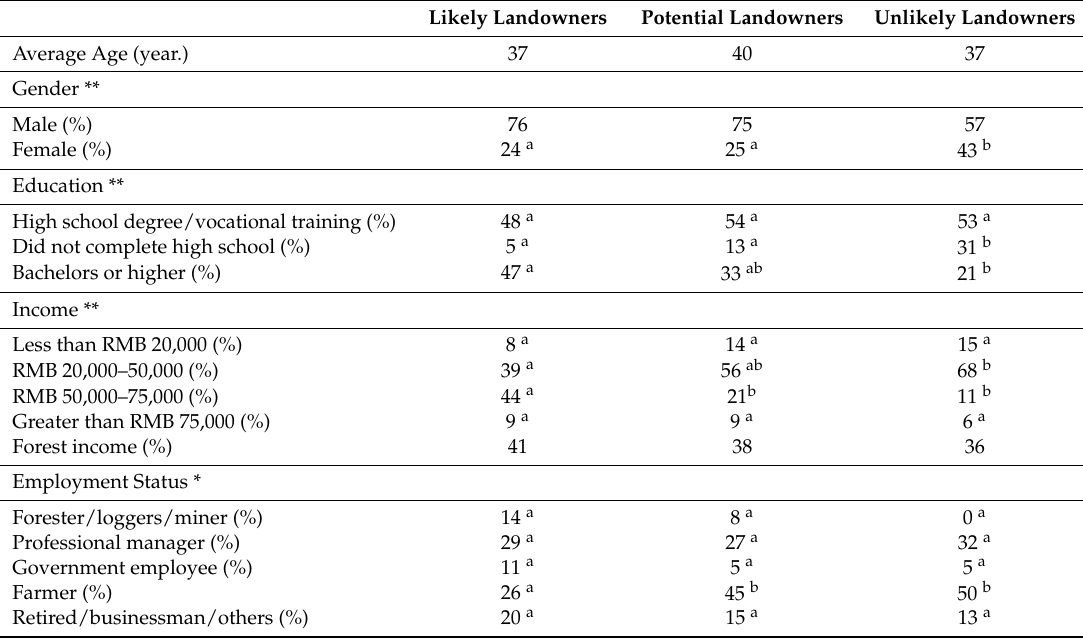
Table 2. Demographics by landowners group.